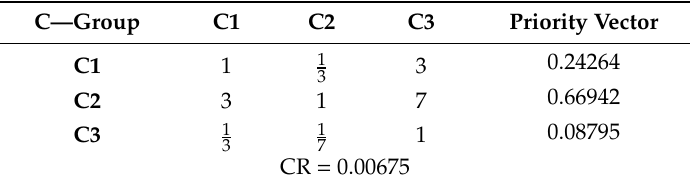
Table 4. Comparison matrix for Cost criteria group.